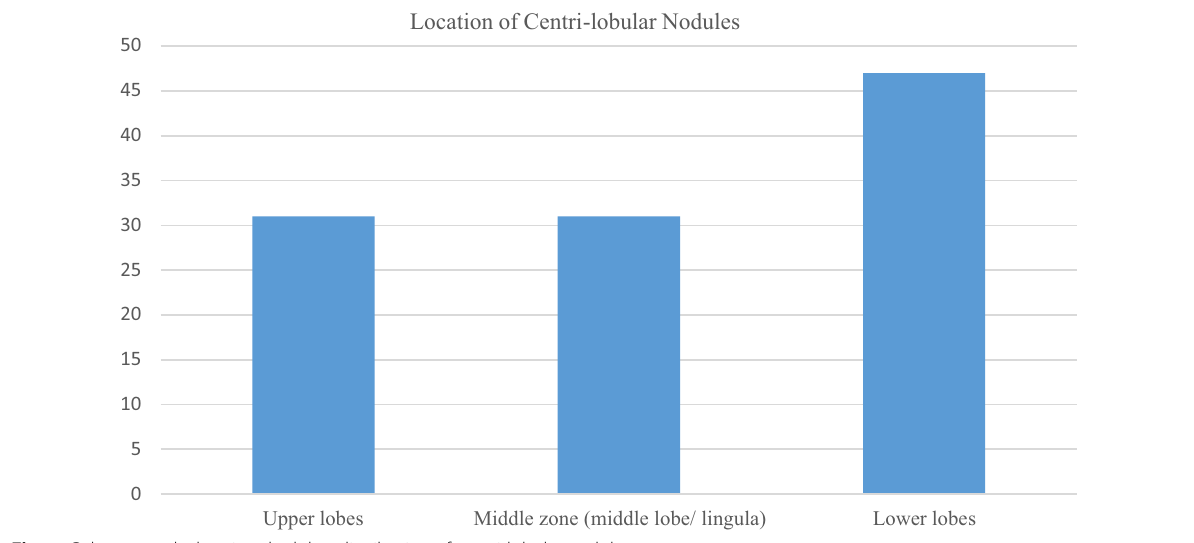
Fig. 1 Column graph showing the lobar distribution of centri-lobular nodules